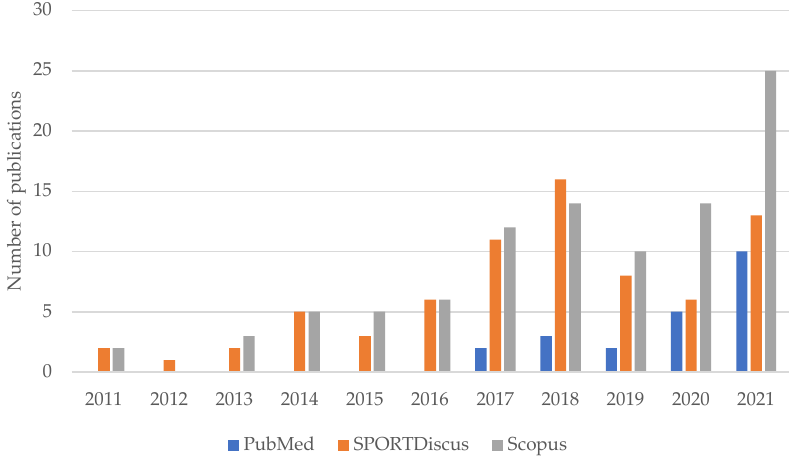
Figure 1. Articles containing the terms “padel” or “paddle tennis” in their title and/or abstract referring to the sport published in the databases PubMed, SPORTDiscus, and Scopus in the last 10 years (self-made figure).